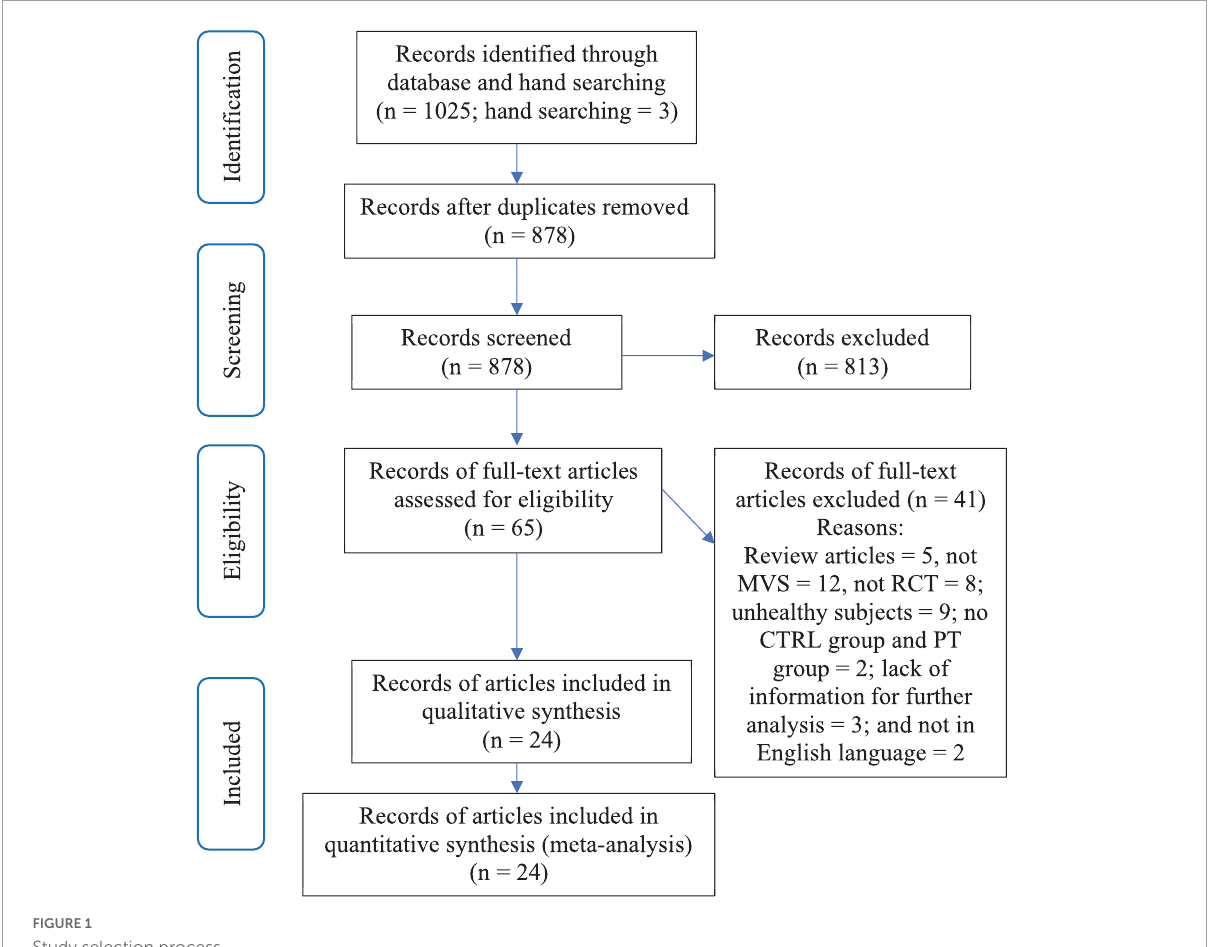
FIGURE1 Study selection